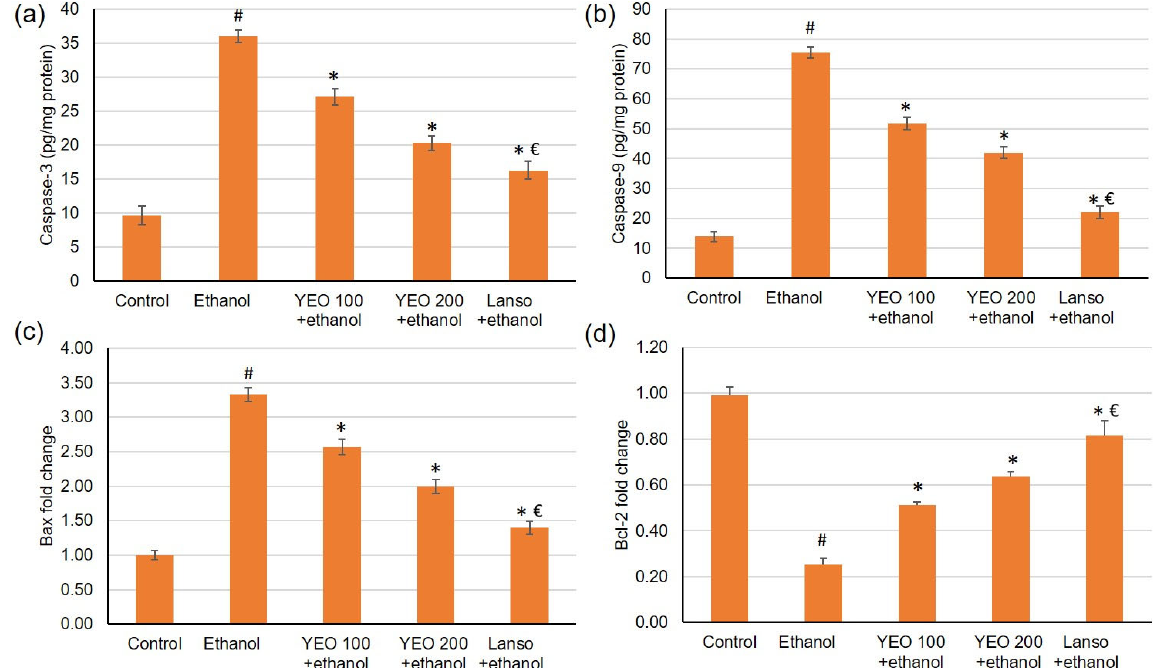
Figure 6. Effects of YEO (100 and 200 mg/kg) administration in acute gastric mucosal injuries induced via ethanol in rats on apoptotic indicators including ( a ) caspase-3, ( b ) caspase-3 and 9, and the gene expression of ( c ) Bax and ( d ) Bcl2. All data are quantified as mean ± SE, ( n = 6 ). (#) defines statistically significant related to the control, (*) signifies statistically significant related to the ethanol-induced gastric mucosal injuries, and (€) designates statistically significant related to YEO 200 + ethanol via one ‐ way ANOVA afterwards Tukey’s post hoc test ( p < 0.05).